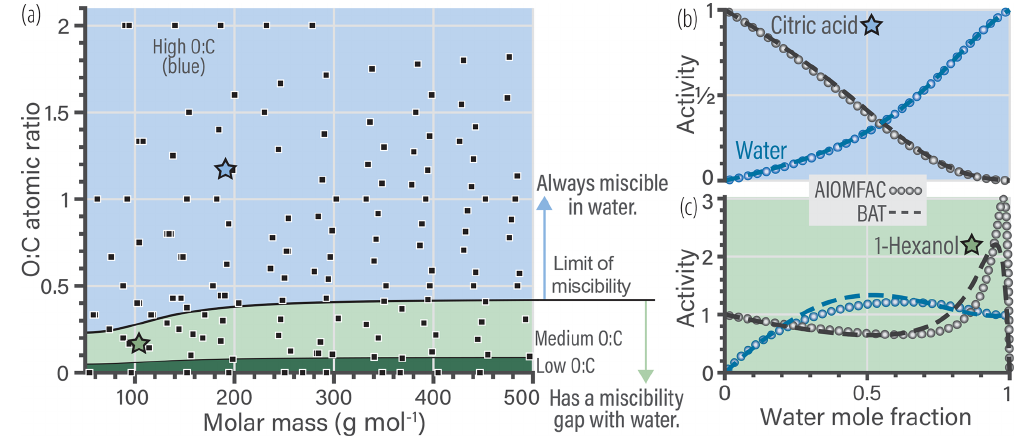
Figure 2. (a) The 160 molecular structures (black symbols) used in optimizing the BAT model for hydroxyl functional groups. The three colored regions indicate distinct sets of BAT model fit parameters: the blue region represents high-O : C, the light green medium-O : C and the dark green low-O : C organic molecules. The black line marks the determined miscibility limit, meaning that at lower O : C, organic molecules exhibit a miscibility gap with water (according to BAT) over a certain composition range, while at higher O : C complete miscibility with water is predicted. (b, c) Comparison of the training data generated by AIOMFAC (open circles) with the BAT model (dashed lines) for two examples: (b) citric acid + water and (c) 1-hexanol + water. Predicted water activity is shown in blue and organic activity in